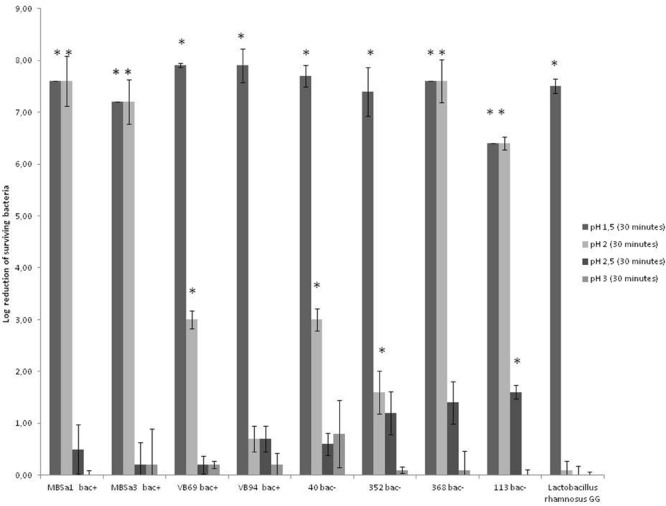
Log reduction of lactic acid bacteria strains after incubation at 37°C for 30 min in (SFG) Simulated Grastric Fluid; 3.2 g/l pepsin and 2 g/l NaCl (pH 1.5–3). Log reductions were estimated by subtracting the log of surviving to the controls (bacteria not exposed to simulated gastric fluid). Data are mean ± standard deviations. Superscript ∗ indicates a significant difference (p < 0.05) compared to the control. Detection limit is 10 CFU/ml.